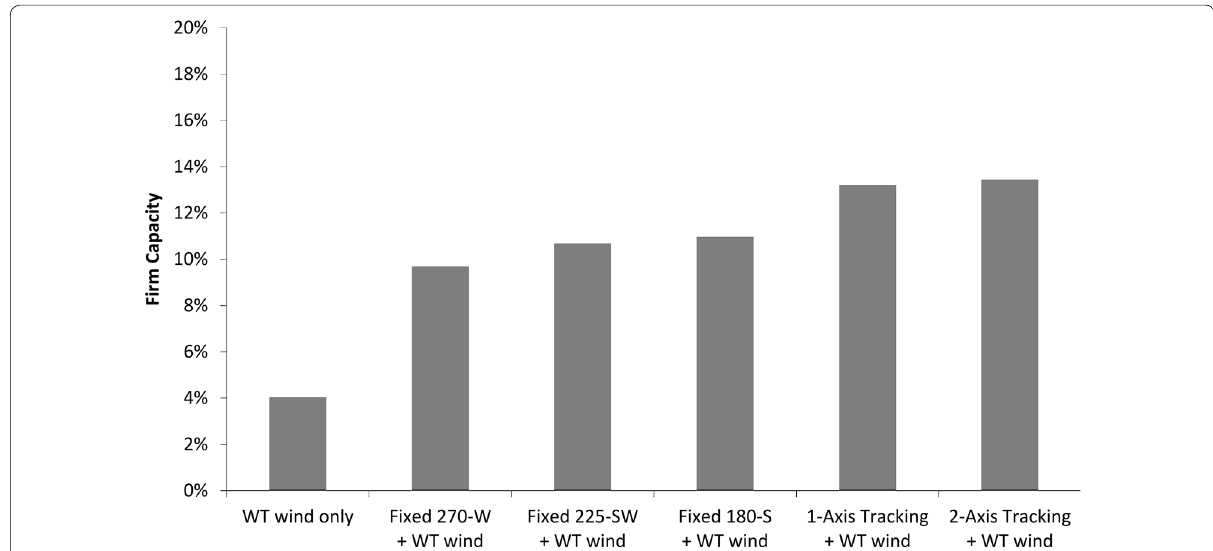
Fig. 7 Capacity factors of various configurations of solar arrays at Roserock for 2012 overall, and during peak load hours of summer and winter